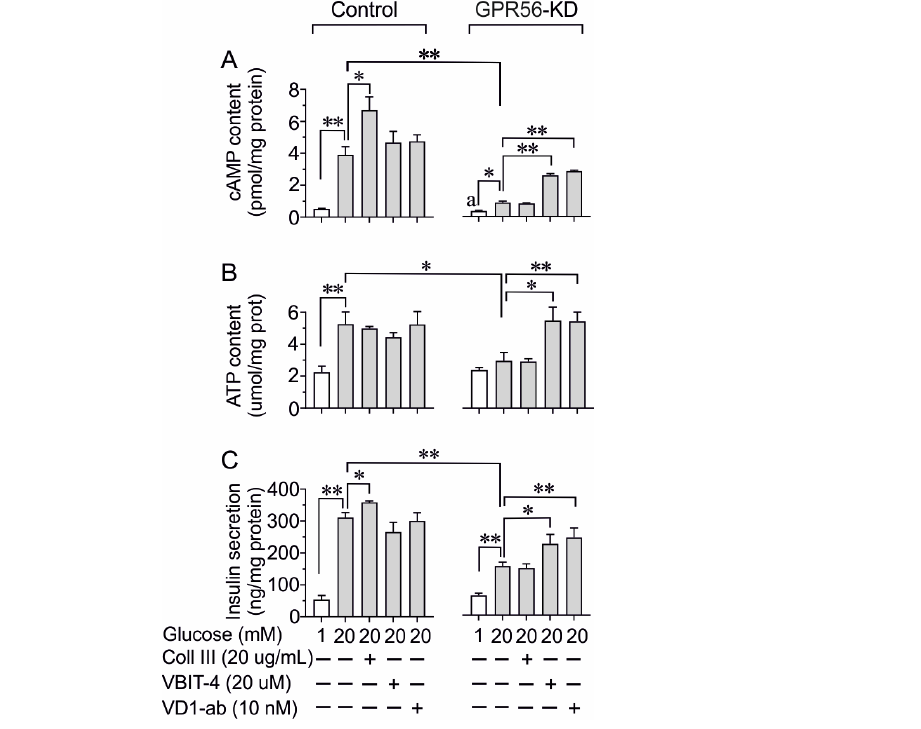
Figure 4. The effect of Coll III, VBIT-4, or VDAC1 antibodies (VD1 ab) on glucose (20 mM)-stimulated cAMP ( A ) and ATP content ( B ) as well as insulin secretion ( C ), in scramble control and GPR56- KD INS-1 832/13 cells. The cells were incubated at 1 or 20 mM glucose for 1 h. For comparisons cAMP and ATP content with insulin release, at basal glucose is included. Mean ± SEM for three experiments performed at different occasions (with three rep-licates in each group) are shown. *, p < 0.05; **, p < 0.01.